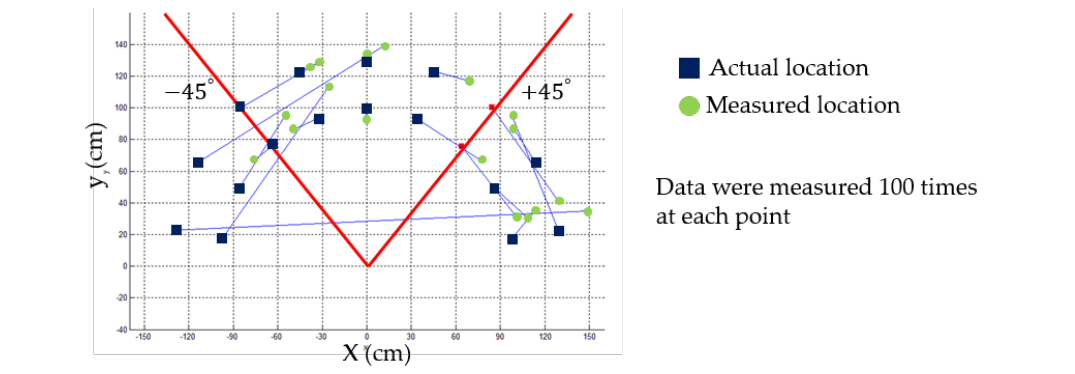
Figure 10. Control region of the mobile robot.